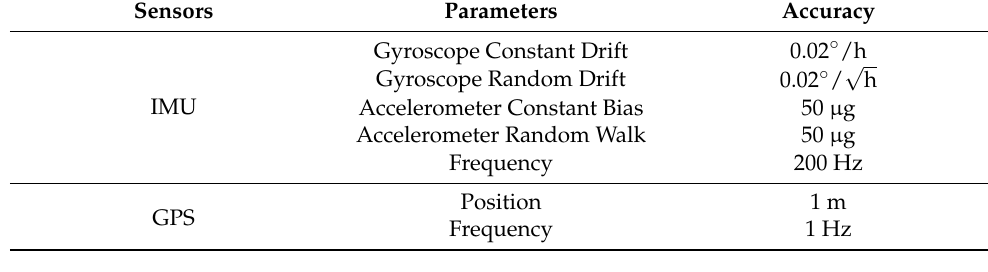
Table 1. Specific of IMU and GPS parameters.